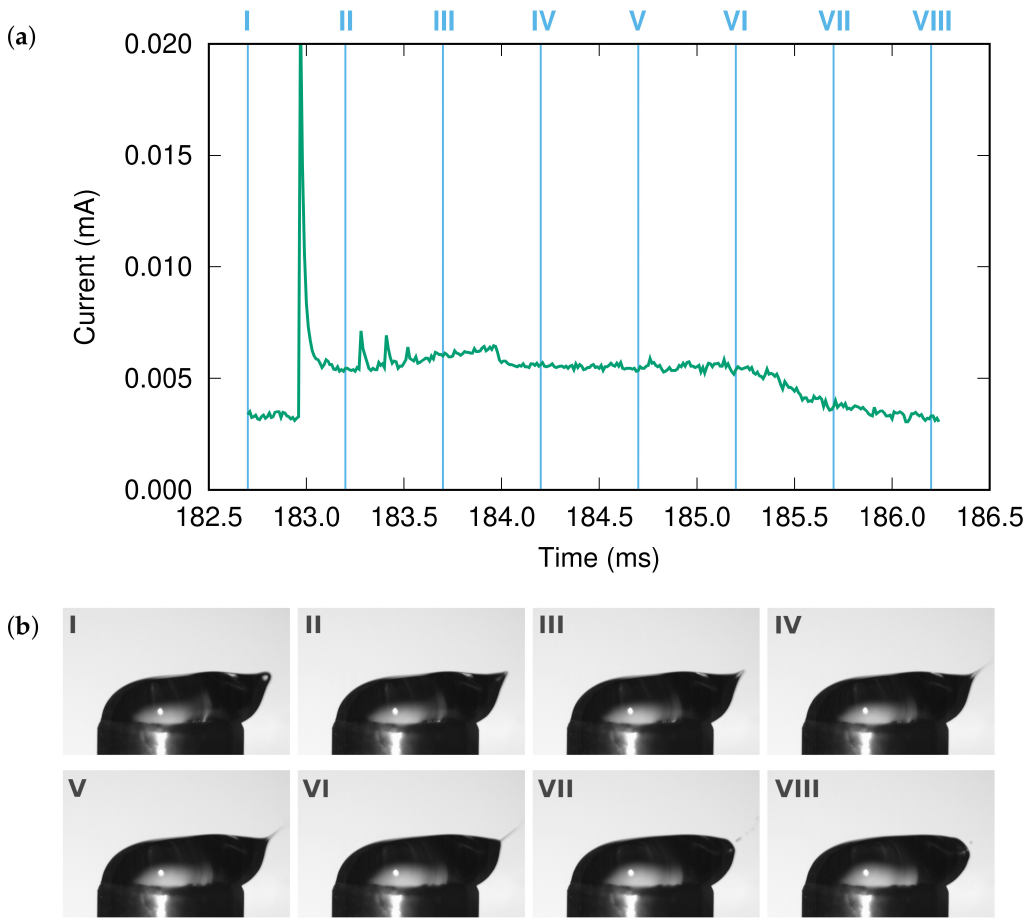
Figure 29. ( a ) Current through electrodes as a function of time measured from the introduction of voltage. ( b ) A sequence of photographs taken at the times corresponding to blue vertical lines (with matching Roman numerals) in the plot above. The experiment was done in setup I with sample a0 at 24.6 ◦ C and 41% relative humidity. Photographs were exported from the record of the Olympus i-SPEED 720 high-speed camera using i-SPEED Software Suite [52].